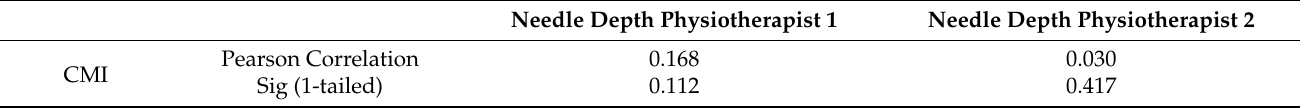
Table 2. Correlation between the BMI and the needle depth.